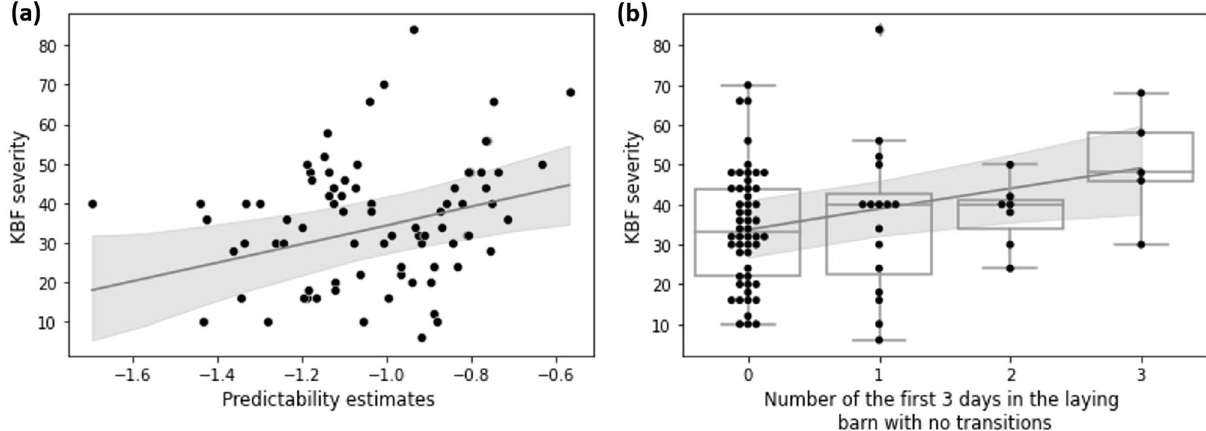
Figure 2. Raw data points of KBF severity in relation to individual predictability ( a ) and the number of days with no transitions during the first three days in the laying barn ( b ), together with the predictions line and its 95% credible intervals from the bivariate